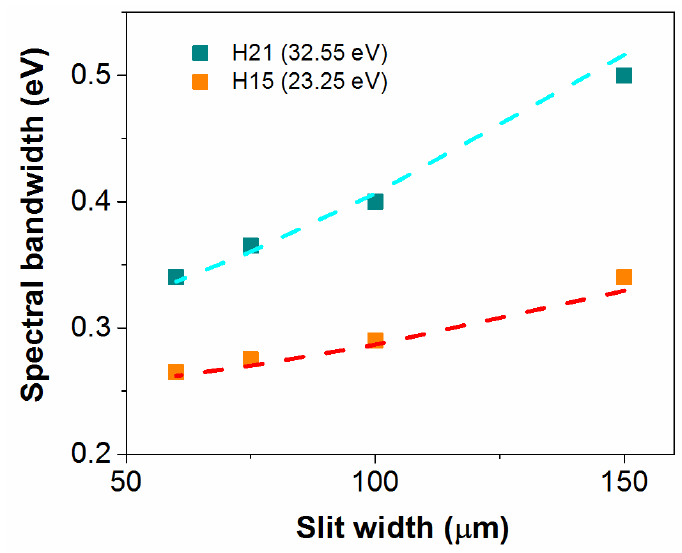
Figure 9. HHG EUV spectral bandwidth measurements as a function of monochromator slit width, grating G3. The dashed lines are simulation results.